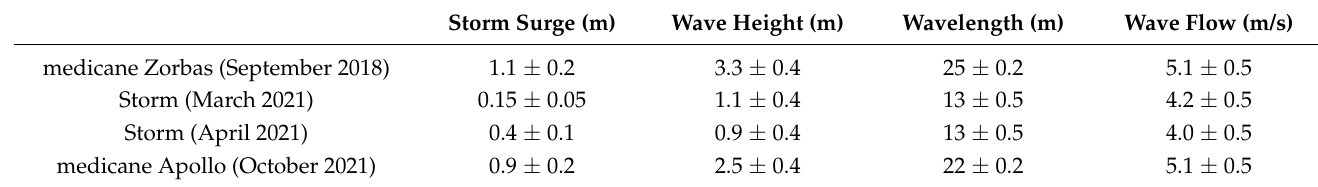
Table 4. Average values of marine parameters obtained through CNN and Optical Flow (relationship (1)) on the video records of medicanes and storm events.